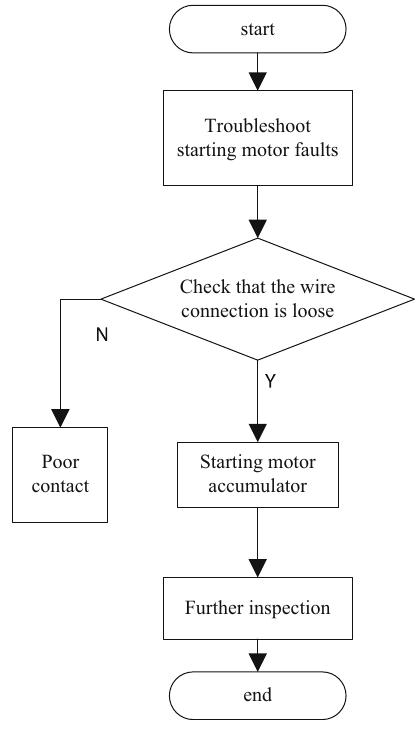
Figure 5: Motor operation inspection